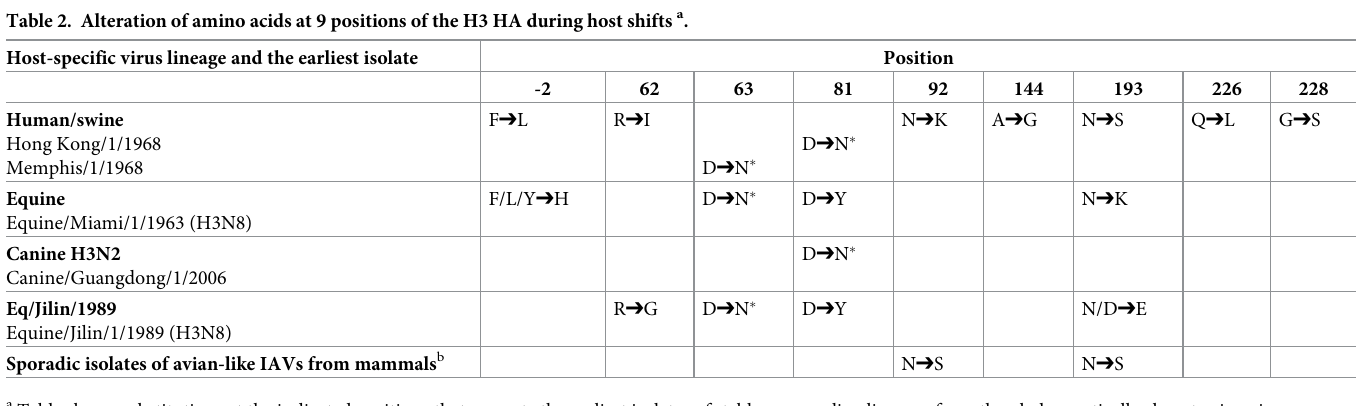
Sporadic isolates of avian-like IAVs from mammals b a Table shows substitutions at the indicated positions that separate the earliest isolates of stable mammalian lineages from the phylogenetically closest avian viruses. Empty cells indicate a lack of changes. Asterisk next to N indicates that substitution generates glycosylation site. The analysis was performed using 2489 HA sequences depicted in the Figs 10, S5 and S6.